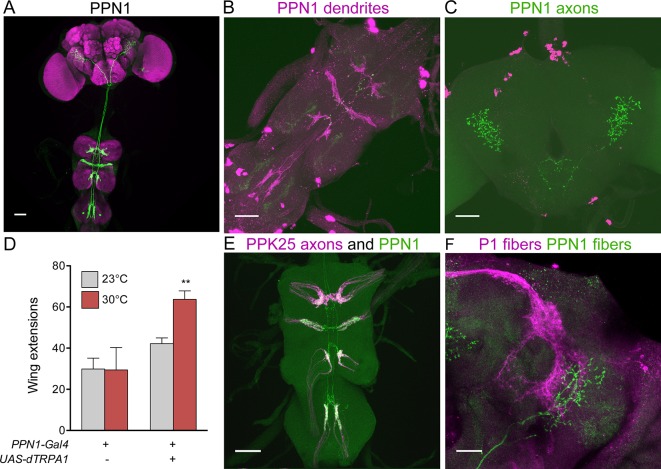
PPN1 neurons are courtship-promoting neurons in proximity to PP23 axons and P1 fibers.(A) PPN1 neurons have cell bodies in the third leg neuromere of the VNC and send projections to the six leg neuromeres and wing neuromere of the VNC and to the ventrolateral protocerebrum of the brain. R56C09-Gal4 drives expression of UAS-CD8::GFP exclusively in the pair of PPN1 neurons. (B-C) PPN1 has dendrites in the VNC (B, DenMark, magenta) and axons in the ventrolateral protocerebrum (C, syt-GFP, green). B and C are from the same animal containing R56C09-Gal4, UAS-DenMark, UAS-synaptotagmin-GFP. (D) Activation of PPN1 with dTRPA1 causes increased male-female courtship at 30°C; mean ± SEM, n = 16–30/condition, **p<0.01 (2-way ANOVA, Bonferroni post-hoc). (E) Overlap is observed in the VNC between PPN1 dendrites (green) and incoming PPK25 axons (magenta). R56C09-LexA, lexAop-CD2::GFP, ppk25-Gal4, UAS-CD8::tdTomato flies were used. F. Overlap between PPN1 (green) and P1 (magenta) in the anterior ventrolateral protocerebrum (50 μm collapsed Z-stack). Scale bars, 25 μm (F) 50 μm (A-E).